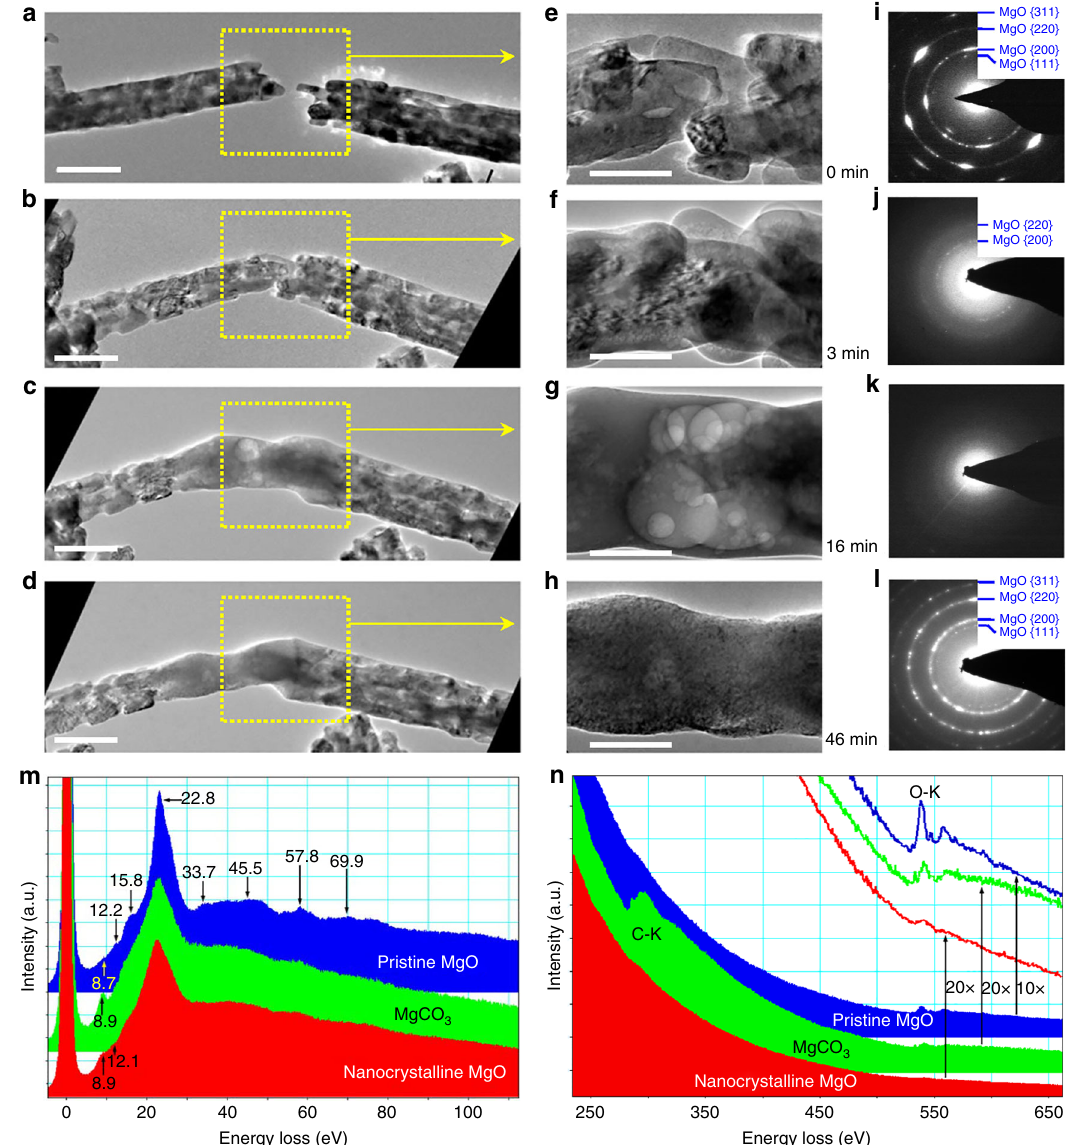
Fig. 3 Structure evolution of the nanowelding process. a , e Two MgO nanowires brought into close proximity prior to the welding. b , f Upon connecting the two MgO nanowires, CO 2 is pumped into the ETEM chamber. Under e-beam irradiation in a CO 2 environment, the MgO carbonation reaction starts immediately. c , g The two MgO nanowires welded together. Plenty of voids were found in the weld. d , h After removing CO 2 from the ETEM chamber and continuing irradiation on the welded spot, the microstructure of the weld spot changes from grey amorphous contrast to nanocrystalline. c , g Plenty of nano-pores exist in the MgO after irradiation in the CO 2 environment for 3 min. The sharp diffraction rings from the pristine MgO ( i ) become dim, and the amorphous content gradually increases ( j , k ). h The bubbles in the MgCO 3 gradually disappear, and in the end, the original porous, amorphous MgCO 3 transforms into a dense nanocrystalline MgO ( l ). m , n Low-loss and core-loss EELS from the pristine MgO, MgCO 3 and the nanocrystalline MgO originate from the decomposition of MgCO 3 . The pristine MgO shows seven characteristic low-loss peaks at 12.2, 15.8, 22.8, 33.7, 45.5, 57.8 and 69.9 eV. The peaks at 532 and 538 eV arise from the O-K edge. Note that C is only present in the MgCO 3 (green pro fi le in n ), which is not found in the pristine MgO (blue plot in n ) and the nanocrystalline MgO (red plot in n ). Scale bars: ( a – d ) 500 nm; ( e – h ) 200